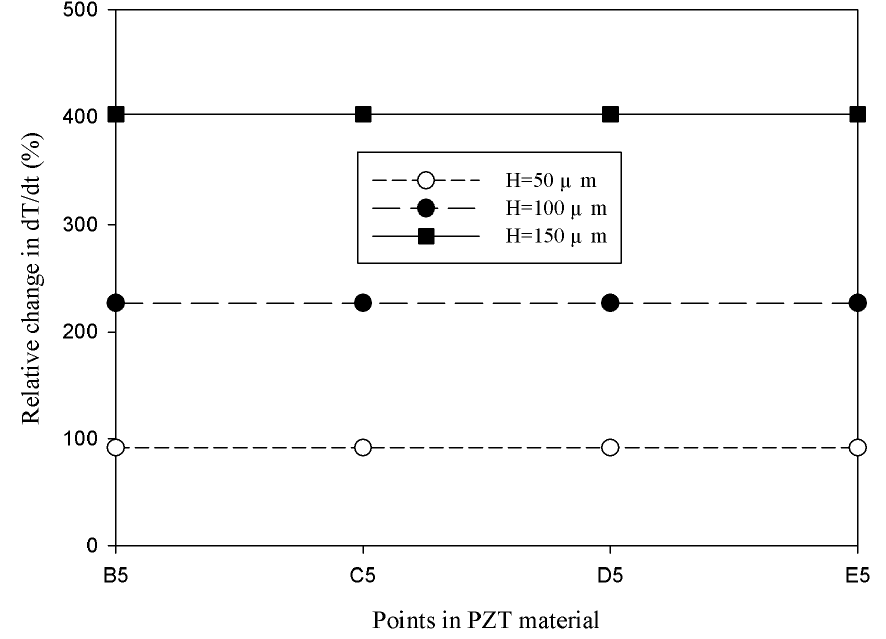
Figure 12. Simulated relative change in the maximum peak value of the temperature variation rate at points B5, C5, D5 and E5 for the mesh top electrode with cavities in the PZT material, compared with that at point A5 for the fully covered electrode, with an electrode width of 50 μ m and etching depths of 50, 100 and 150 μ